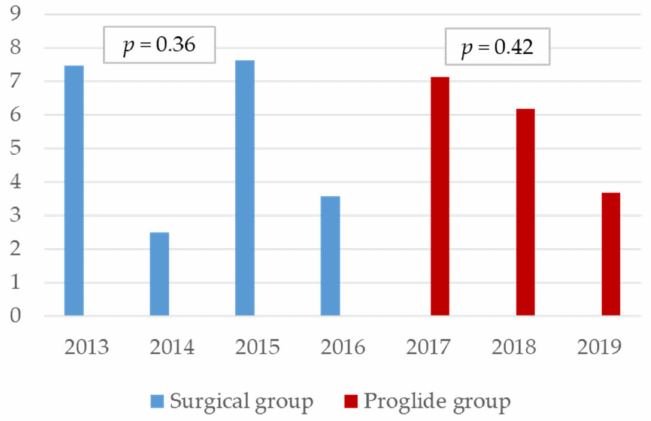
Figure 2. Occurence of the primary endpoint over time (expressed as percentage per